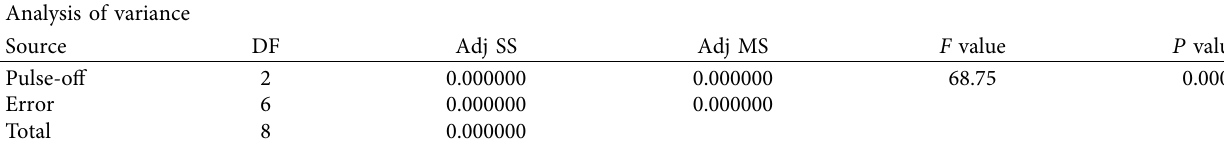
Table 15: One-way ANOVA: MRR vs. pulse-on time for mild